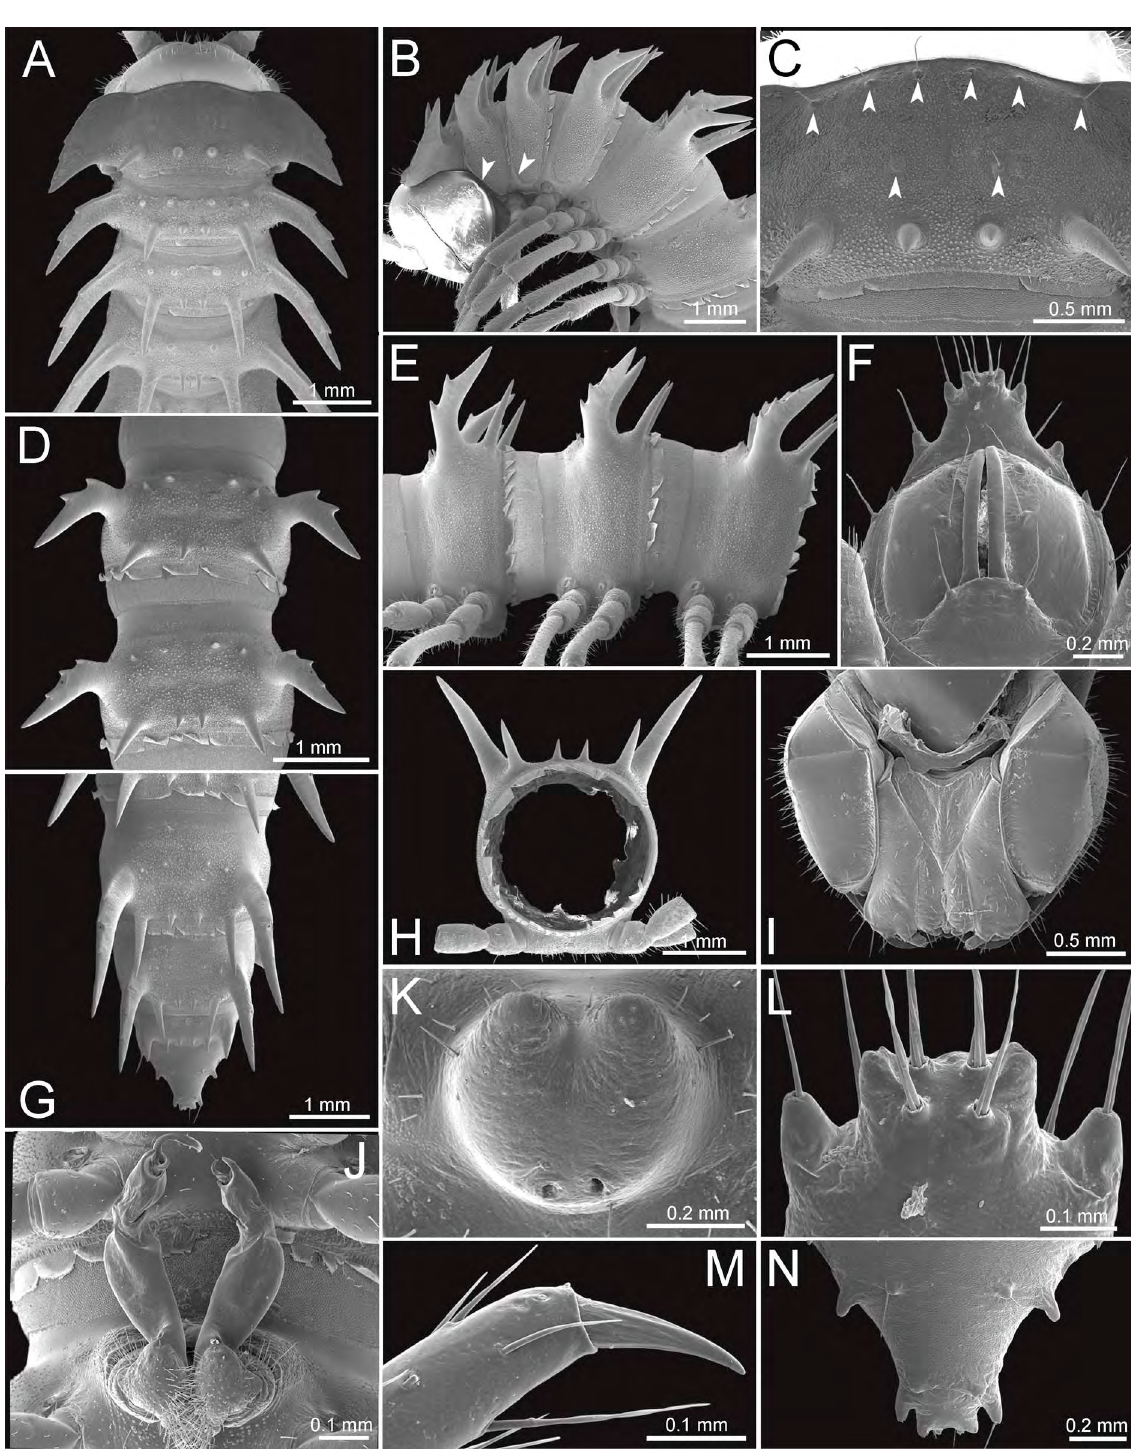
Fig. 3. General body characters of Nagaxytes Srisonchai, Enghoff & Panha gen. nov. ( N. erecta Srisonchai, Enghoff & Panha gen. et sp. nov., specimen from Prang Ka Sri Temple, Thailand), SEM images. A – B . Anterior body part (arrowheads point to pleurosternal carinae). C . Collum (arrowheads point to the setae/tubercles of the anterior and intermediate rows). D . Body rings 9–10. E . Body rings 8–10. F . Telson. G . Posteriormost rings and telson. H . Body ring 10. I . Mouth parts, ventral view. J . Gonopods in situ. K . Sternal lobe between male coxae 4. L , N . Tip of epiproct. M . Tarsus and claw of leg